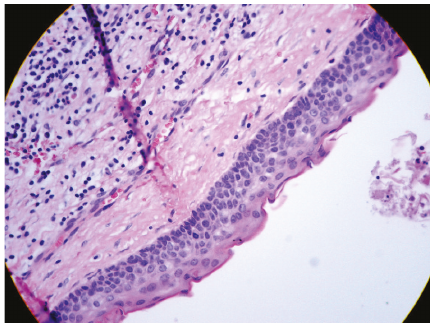
Figure 2: The characteristic corrugated surface of the epithelium, with a polarized layer of palisaded basal cells, and keratin stripped of the HE × 40.